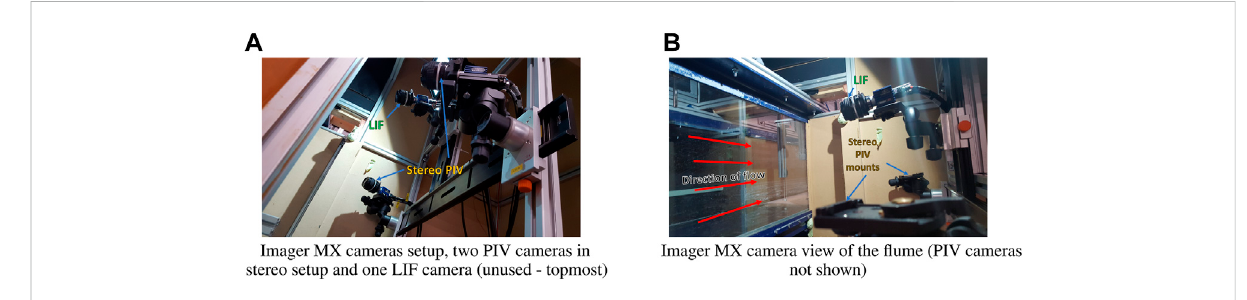
FIGURE 1 PIVcamerasetupforexperimental fl owvalidation. (A) ImagerMXcamerassetup,twoPIVcamerasinstereosetupandoneLIFcamera(unused-